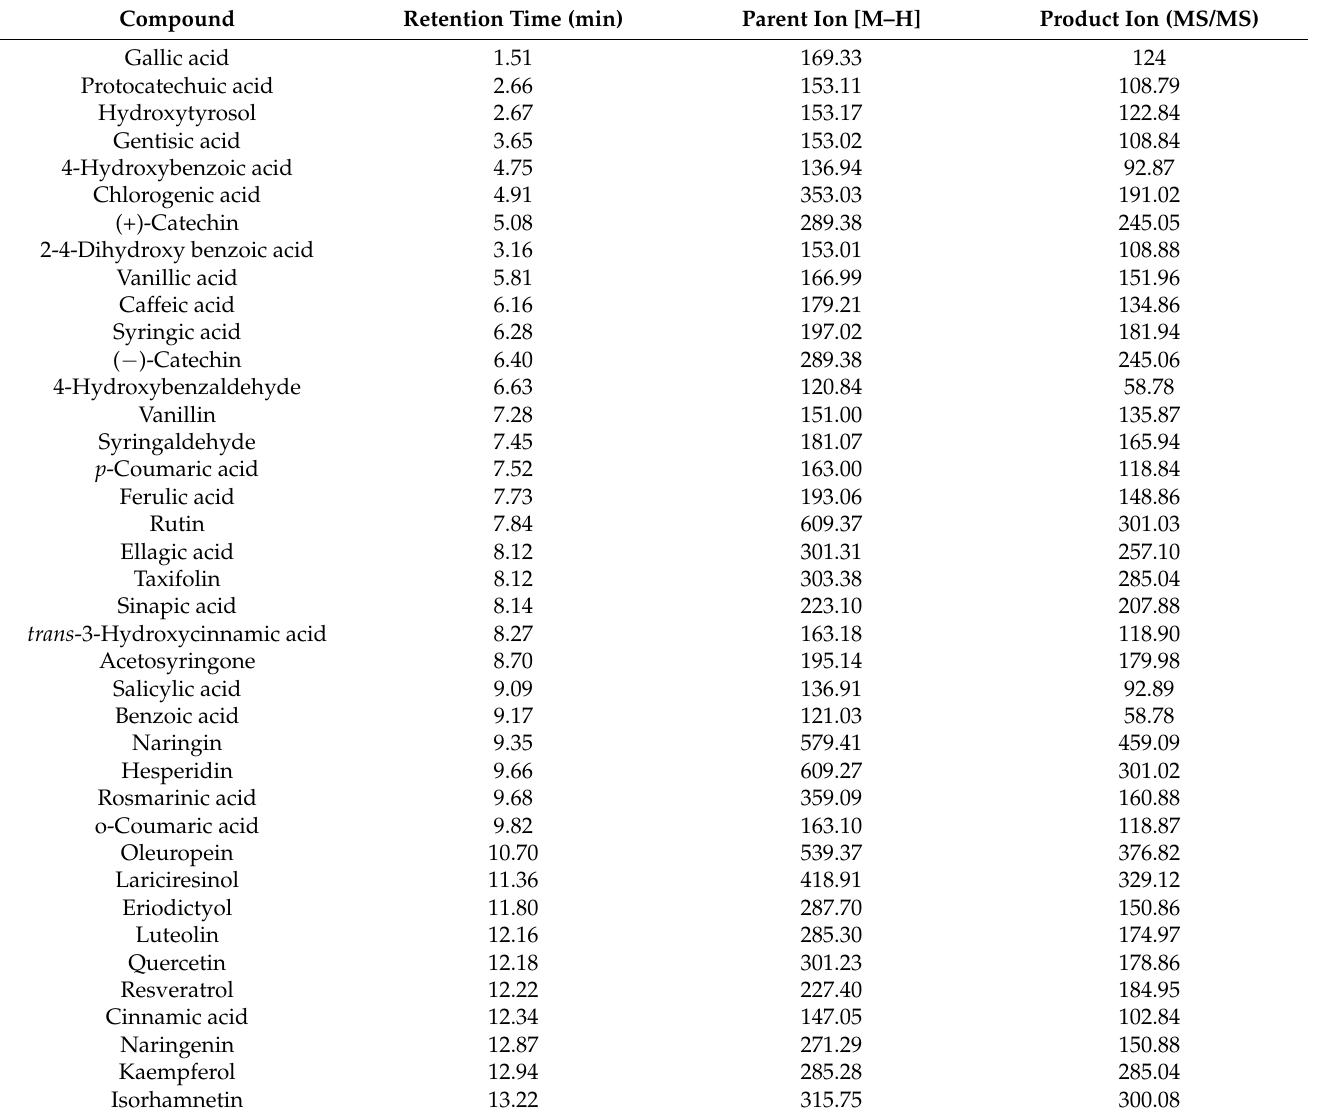
Table 1. Spectral information of LC-MS/MS analysis of phenolic